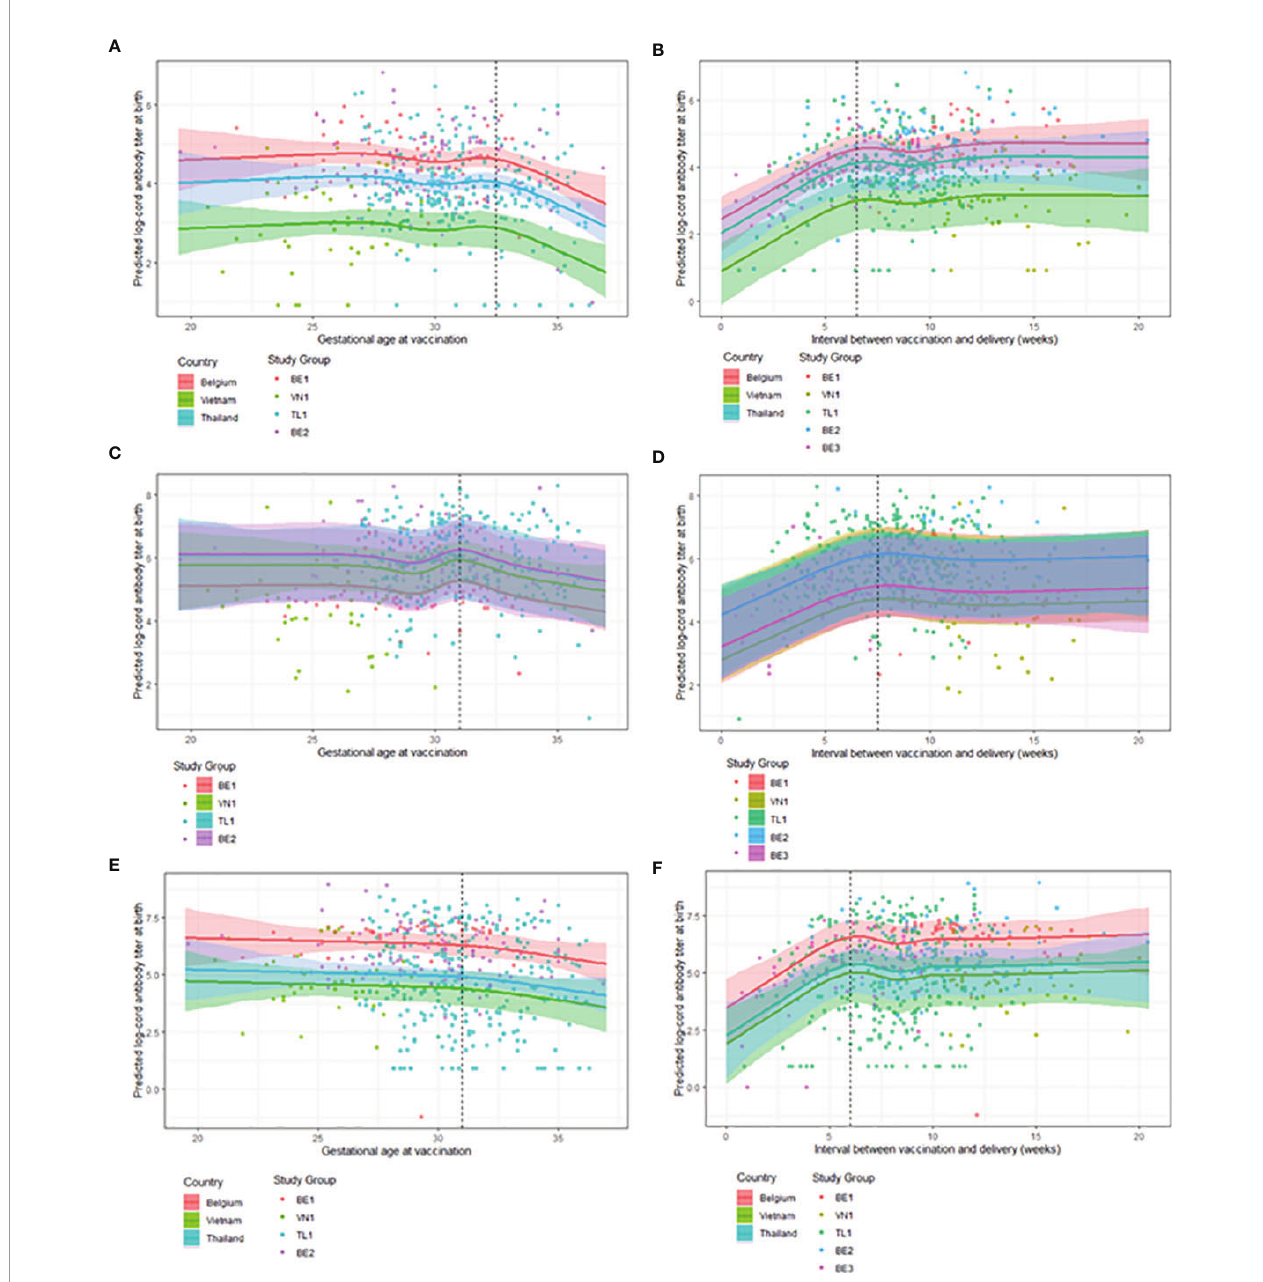
FIGURE 2 | Observed GMCs (points) and model estimates (solid line) with 95% con fi dence intervals (shaded area) for antibody titers across covariates. Note, results of the LMMs are presented as graphical representations, keeping stated covariates constant to visualise the effect of timing of maternal vaccination on cord antibody titers. (A) Model 1: GMC estimates for cord anti-PT titers at delivery by GAV across country with covariates: weight = mean birth weight, BA-EDD = 0 days. (B) Model 2: GMC estimates for cord anti-PT titers at delivery by interval between GAV and GAD across country with covariates: weight = mean birth weight. (C) Model 3: GMC estimates for cord anti-FHA titers at delivery by GAV across study groups with covariates: weight = mean birth weight, vaccine = Boostrix ® . (D) Model 4: GMC estimates for cord anti-FHA titers at delivery by interval between GAV and GAD across study groups with covariates: weight = mean birth weight. (E) Model 5: GMC estimates for cord anti- PRN titers at delivery by GAV across country with covariates: weight = mean birth weight, age = mean age of mother at birth. (F) Model 6: GMC estimates for cord anti- PRN titers at delivery by interval between GAV and GAD across country with covariates: weight = mean birth weight, age = mean age of mother at birth, being term born. BA-EDD = number of days delivered before/after the due date, GAD = gestational age at delivery, GAV = gestational age at vaccination, GMC = geometric mean concentration, BE1 = Belgium 1, VN1 = Vietnam 1, TL1 = Thailand 1, BE2 = Belgium 2, BE3 = Belgium 3, PT = Pertussis Toxin, FHA = Filamentous Haemmaglutinin, PRN = Pertactin, LMMs = linear mixed